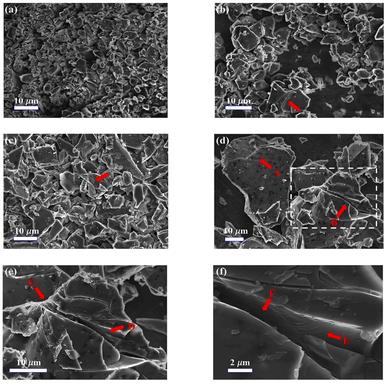
SEM micrographs of deformed particles for the intermediate powder and coarse powder: (a) intermediate powder after quasi-static compaction (QS1000F 2); (b) intermediate powder after dynamic Kolsky bar compaction (D1000F 3) with a transgranular crack labeled by the red arrow; (c) deformed coarse powder from quasi-static compaction (QS220F 2) with the red arrow pointing a crack; and (d) - (f) dynamically deformed coarse powder by Kolsky bar (D220F 1). Region A shows a particle with a wing crack and region B (